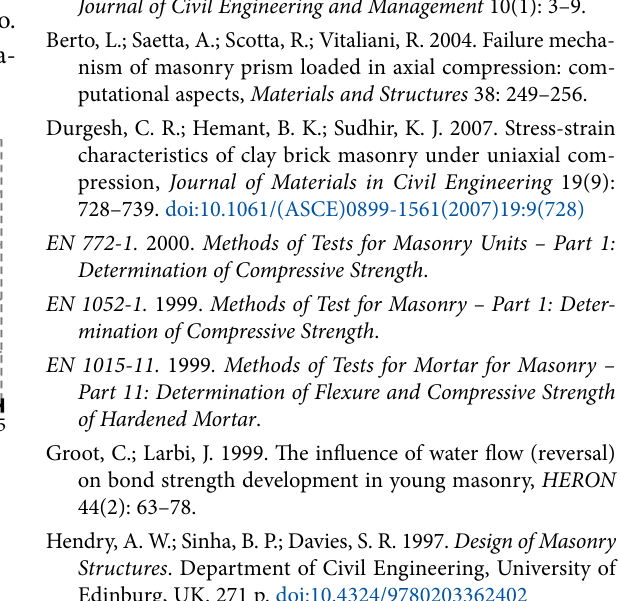
Fig. 12. The variation of elastic modulus of bed joint: 1 – dry units; 2 – wet